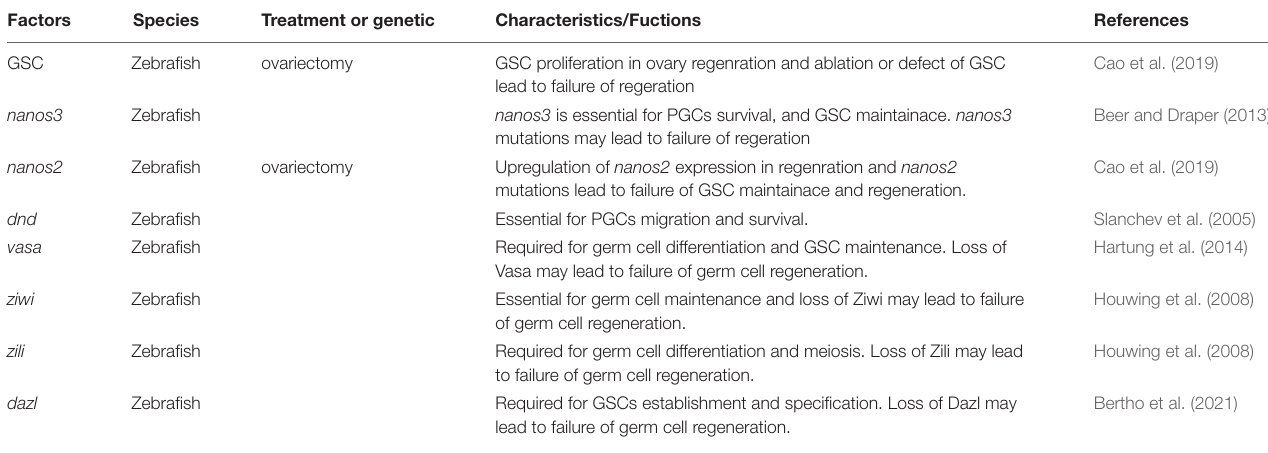
TABLE 2 | Summary of effects of factors contributing to germ cell regeneration.